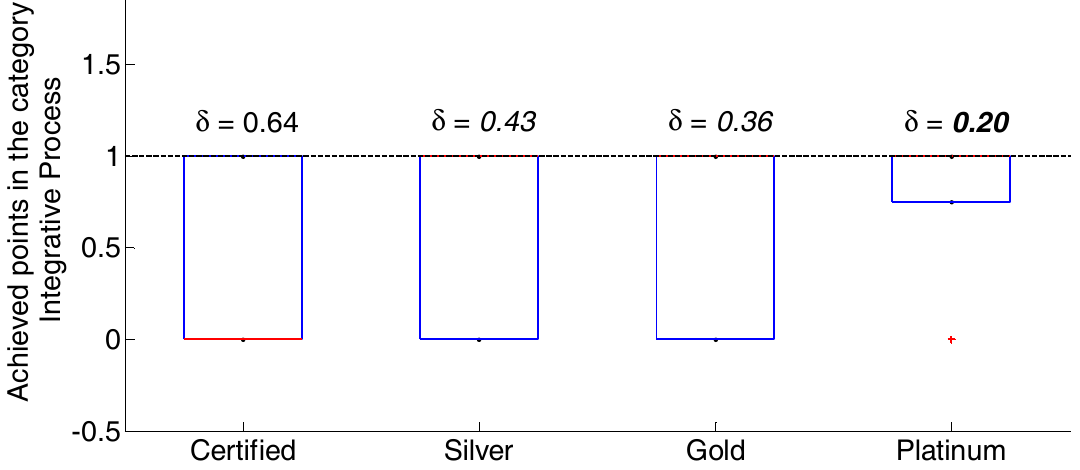
Figure 1. The boxplot results and Cliff’s δ effect size between possible and achieved points in the Integrative Process (IP) category. Effect size is considered to be: very high if | δ | < 0.147 (bold font), high if 0.147 < | δ | < 0.33 (bold italic font), medium if 0.33 < | δ | < 0.474 (italic font), and low if | δ | ≥ 0.474 (normal font).